Question: Sum up the contents of this chart in one sentence.
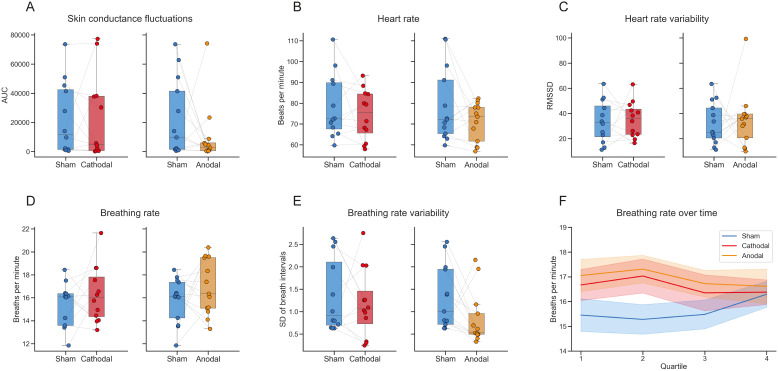
Answer: Unspecific effects assessment via autonomic responses in different stimulation conditions. Comparison of spontaneous skin conductance fluctuations (A), heart rate (B), heart rate variability (C), breathing rate (D), and breathing rate variability (E) between cathodal and sham as well as between anodal and sham conditions, respectively. Note that the sham group does not always consist of the same data points as participants were excluded from specific sessions due to excessive noise (see description in Methods section). (F) Depiction of group-level means and standard error of the mean underlying the significant time-by-condition interaction in breathing rate.